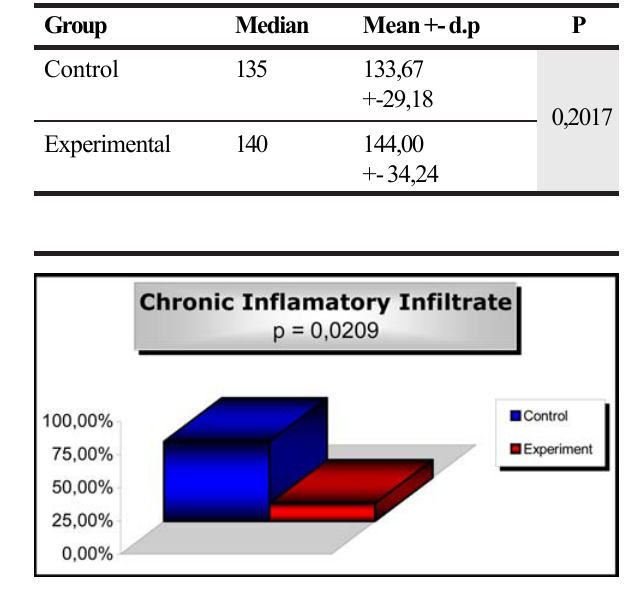
FIGURE 2 - Predominance of chronic inflammatory infiltrate in control group